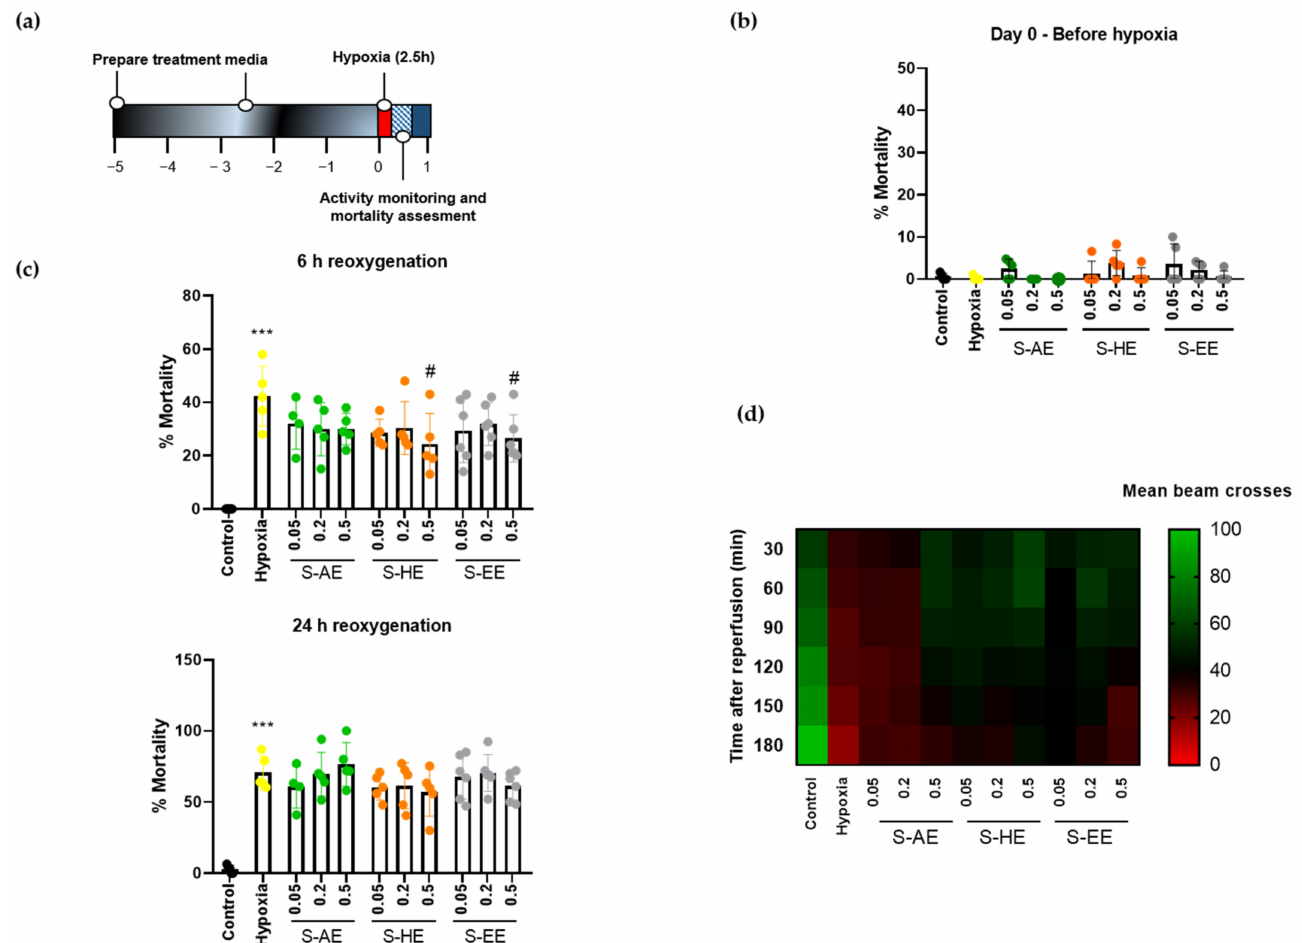
Figure 2. Effect of different concentrations of S-AE, S-HE, and S-EE pre-treatment (mg/mL) on flies exposed to acute hypoxia. ( a ) Schematic illustration of the hypoxia protocol in Drosophila males. ( b ) Mortality rate assessment after 5 days of treatment in normoxia (n = 5 experiments; 150–180 individuals per condition). ( c ) Mortality rate of control and treated flies 6 and 24 h after hypoxia exposure (n = 5 experiments; 136–181 individuals per condition). ( d ) Heatmap displaying the locomotor activity of treated flies (n = 3 experiments; 79–90 individuals per condition). Flies were transferred into the DAM system immediately after hypoxia and activity was recorded for 180 min after reoxygenation. Each cell shows the mean beam crosses per fly. Data were analyzed using one-way ANOVA test followed by Dunnett ´ s multiple comparisons test *** p < 0.001 vs. control; # p < 0.05 vs.